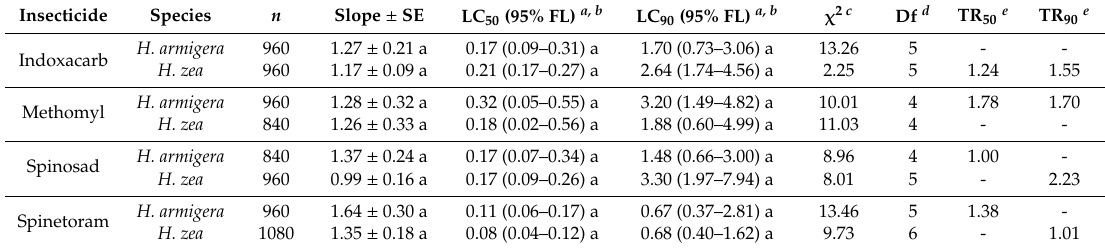
Table 2. Concentration–mortality response (lethal concentration (LC); µ g a.i. / cm 2 ) of the third instar Helicoverpa larvae exposed to the insecticides overlaid on artificial